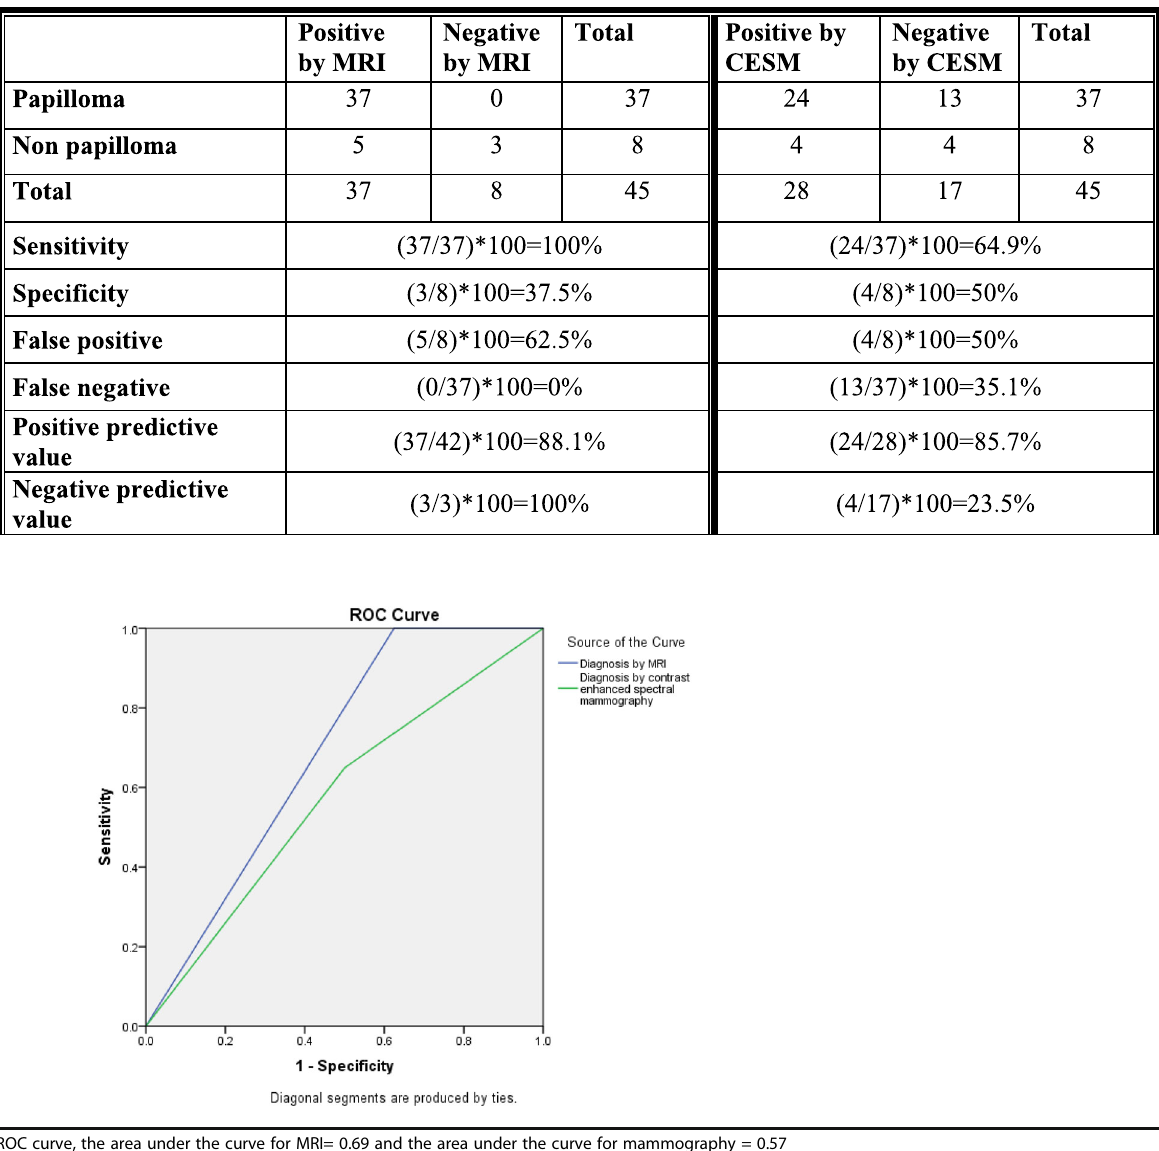
Table 6 Diagnosis of papilloma by MRI &